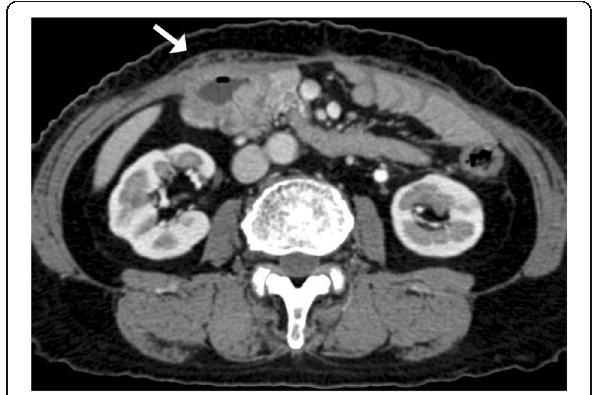
Fig. 1 Contrast-enhanced abdominal CT scan showed wall thickness with enhancement in the second portion of the duodenum and the adjacent abdominal wall